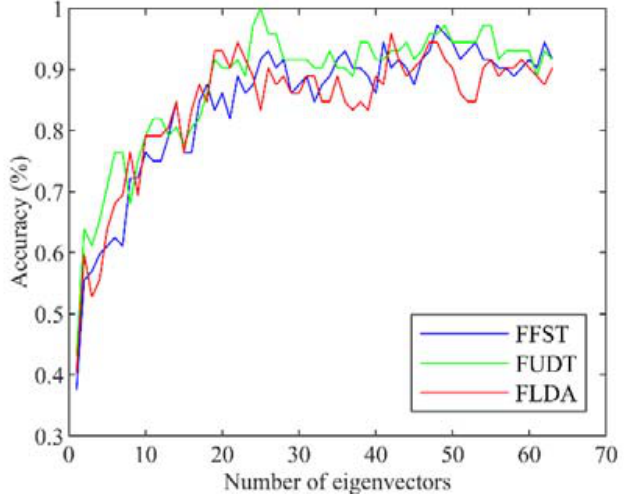
Figure 5. The accuracy rates on the test set when changing the number of eigenvectors.